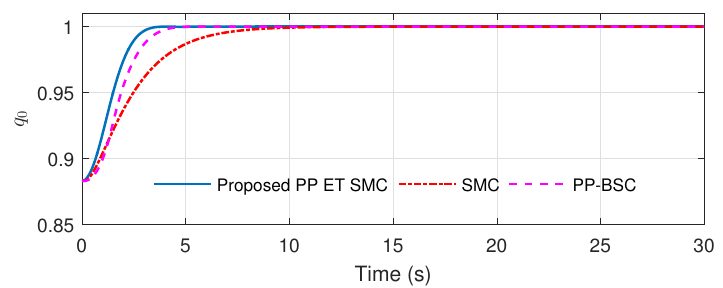
Figure 3. Scalar quaternion